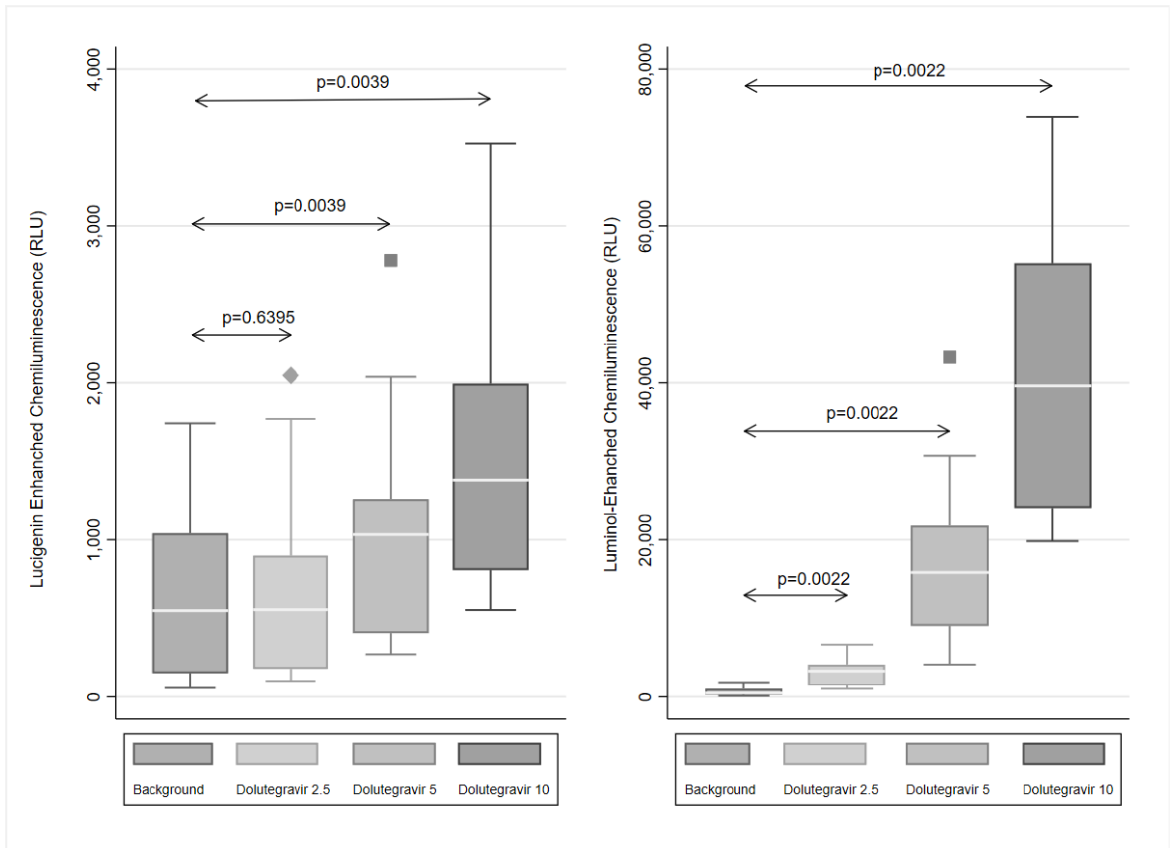
Figure 1. Effects of dolutegravir (2.5–10 µ g/mL) on the spontaneous lucigenin- and luminol-enhanced chemiluminescence responses of neutrophils. The results are expressed as the median peak chemiluminescence values in relative light units (RLU) measured 30 – 50 s after the addition of dolutegravir using Box and Whisker plots. Lucigenin-enhanced chemiluminescence (left graph): n = 5 donors with 9 replicates for each drug concentration and control system, and luminol-enhanced chemiluminescence (right graph): n = 6 with 30 replicates. “Background” refers to the unstimulated DMSO-treated control. p = 0.6395 – p = 0.002 for comparison of the dolutegravir-treated systems with the unstimulated control system.